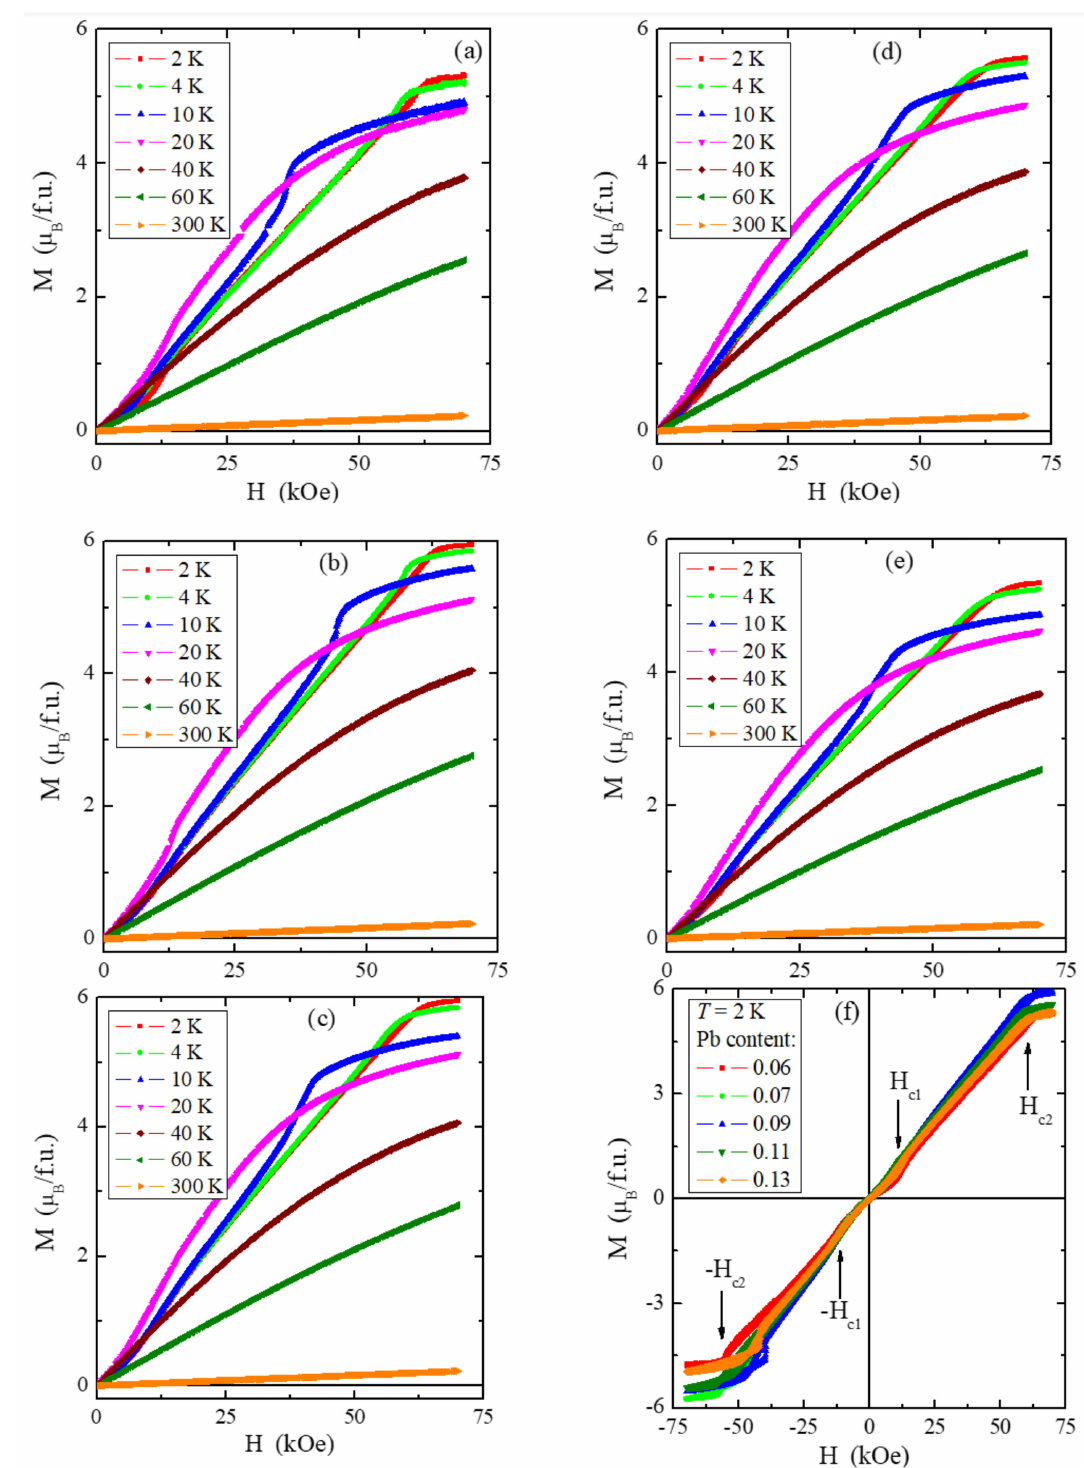
Figure 8. Magnetization M vs. magnetic field H at 2, 4, 10, 20, 40, 60, and 300 K for the ZnCr 2 Se 4 single crystals doped with Pb 2+ ions having contents of 0.06 ( a ), 0.07 ( b ), 0.09 ( c ), 0.11 ( d ), and 0.12 ( e ). The M (H) isotherms recorded at 2 K with arrows denoting the first ( H c1 ) and second ( H c2 ) critical magnetic fields are shown in figure ( f